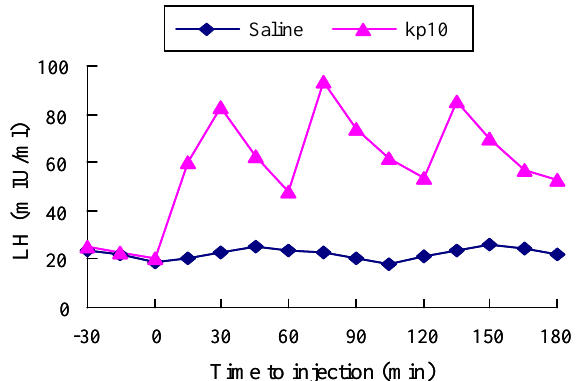
Figure 3. Changes in the serum concentrations of LH over 210 min in prepubertal ewes which received repeated intravenous injection of 1 mg kisspeptin-10 (kp10) dissolved in 5 ml of saline for 3 times at 1-h